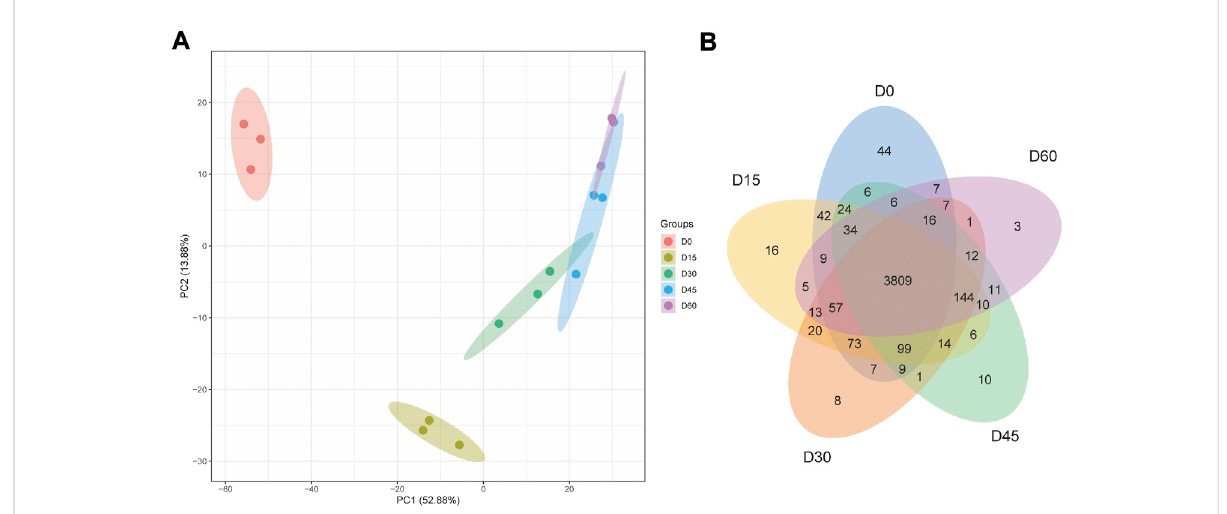
FIGURE 1 PCA scores plot (A) and Venn Diagram (B) of proteins identi fi ed in rumen epithelium at the age of day 0, day 15, day 30, day 45, and day